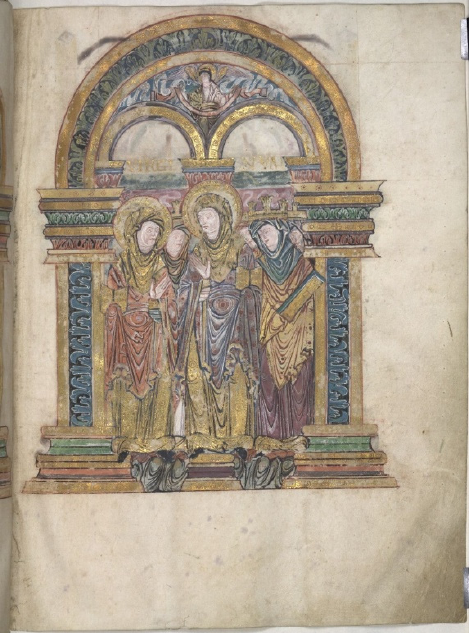
Figure 13. The Benedictional of St Aethelwold , f. 1v: Full-page miniature of the Chorus of Virgins, ca. 963–984 , British Library, London.